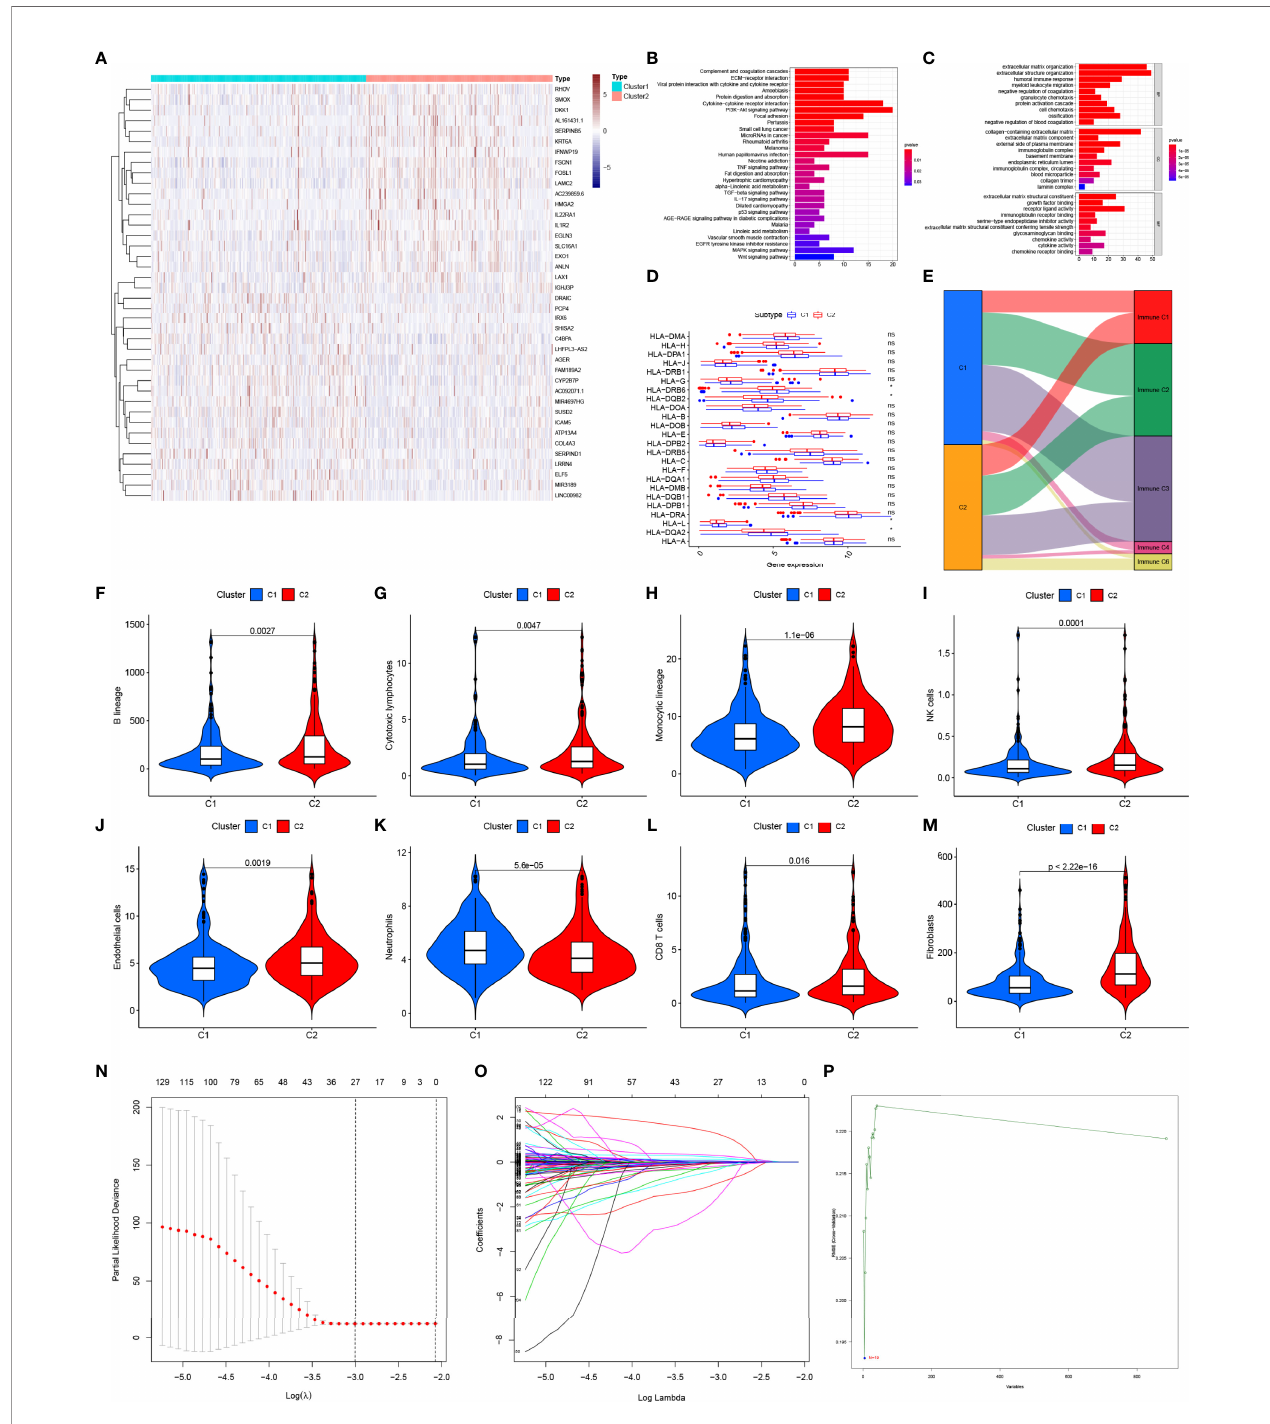
FIGURE 2 | Identi fi cation of pGGO-related DEGs between Cluster 1 and Cluster 2 (A) Heatmap of the pGGO-related DEGs (|log FC|> 1, FDR P < 0.05); (B, C) KEGG (B) and GO (C) enrichment pathways analysis of the pGGO-related DEGs; (D) HLA gene expression data for Cluster 1 and Cluster 2; (E) Sankey diagram showing the relationship between the cluster subtype and six immune subtypes de fi ned in a previous study; (F – M) Violin plots showing the expression of the immune cells in Cluster 1 and Cluster 2; (N – P) Selection of prognostic pGGO-DEGs in Cluster 1 and Cluster 2 using Lasso cox regression (N, O) and SVM-RFE (threshold value = 19) (P) . DEGs, differentially expressed genes; GGO, ground-glass opacity; KEGG, Kyoto Encyclopedia of Genes and Genomes; GO: Gene Ontology; NMF, non-negative matrix factorization; SVM-RFE: support vector machine — recursive feature elimination. ns represent non signi fi cant, * represent P ≤